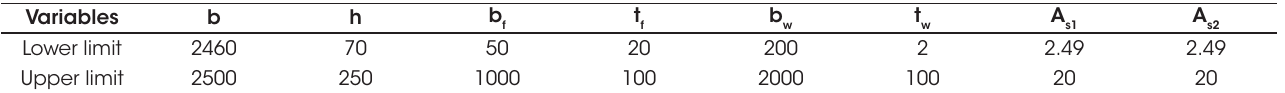
Limit parameter for design variables (dimensions in mm and area in cm 2